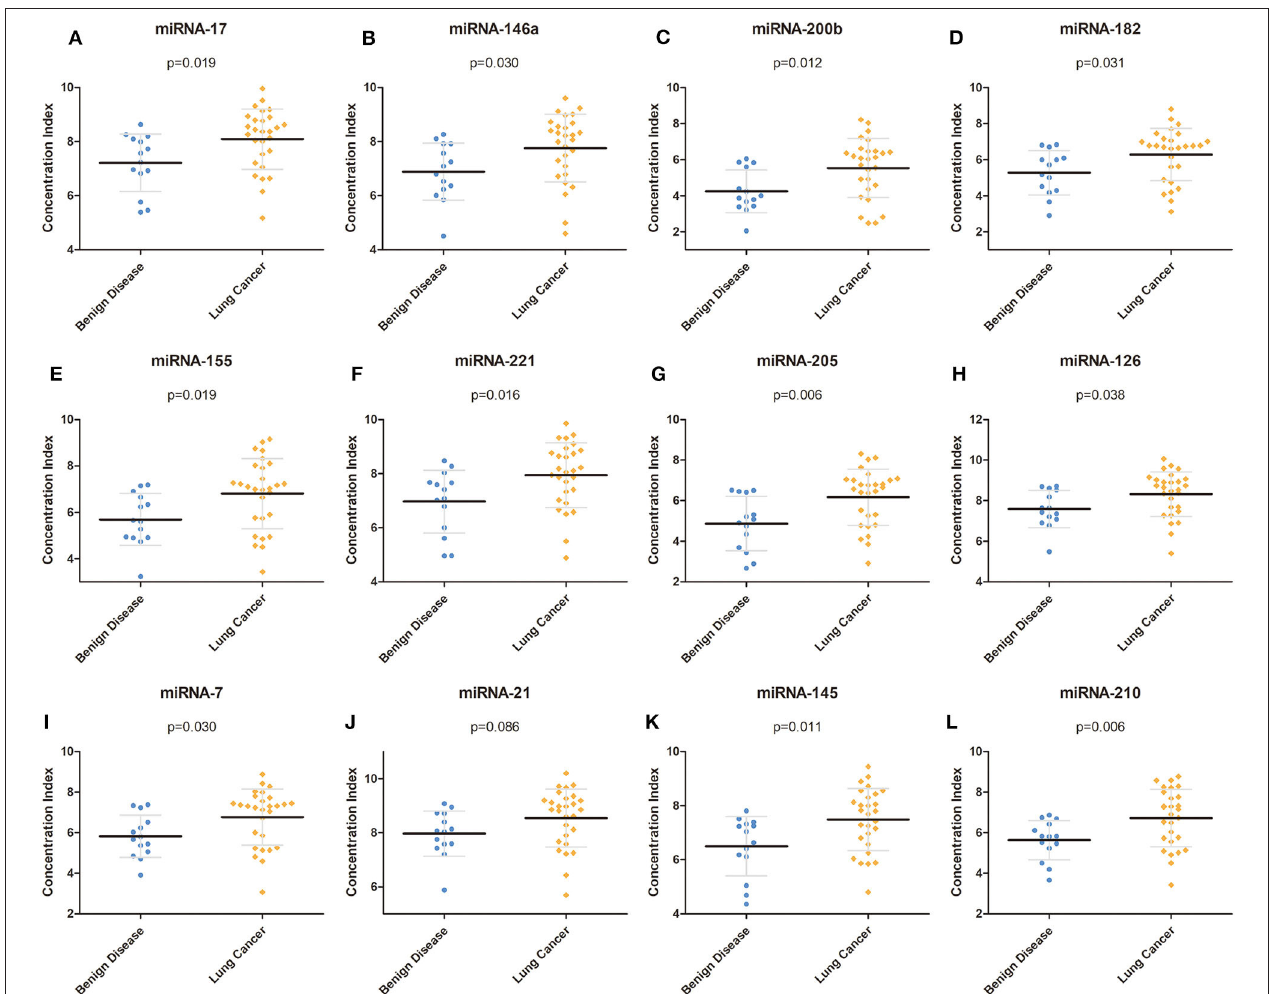
FIGURE 2 | Concentration of each miRNA in the training group. (A–L) Concentrations of miRNA-17, miRNA-146a, miRNA-200b, miRNA-182, miRNA-155, miRNA-221, miRNA-205, miRNA-126, miRNA-7, miRNA-21, miRNA-145, and miRNA-210 in the training group. miRNA,